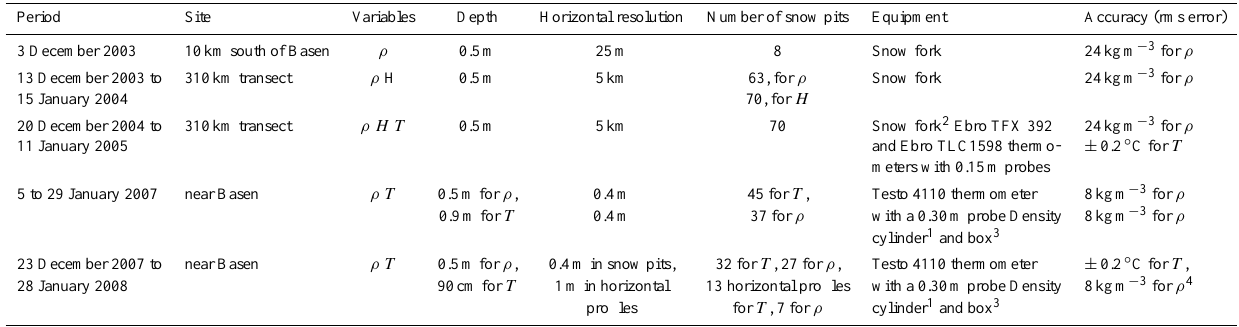
Table 1. Snow measurements. Snow temperature is denoted by T , snow density by ρ , and subjective layer hardness by H . Period Site Variables Depth Horizontal resolution Number of snow pits Equipment 10km south of Basen Snow fork